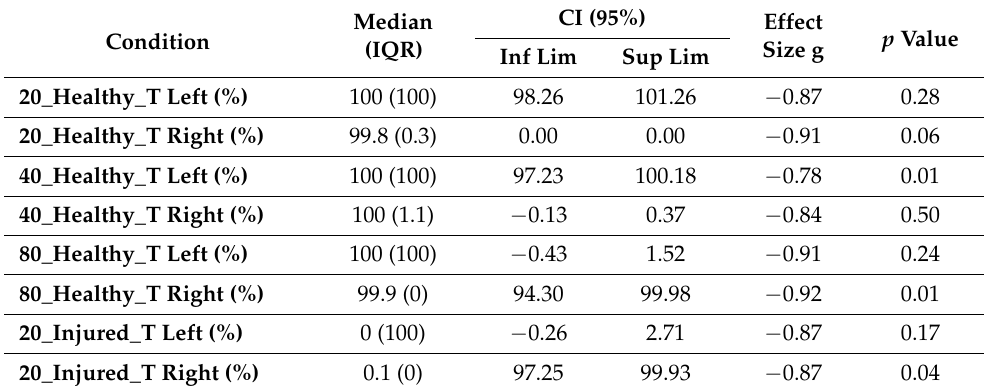
Table A2. Descriptive data (median, interquartile range, coefficient interval 95%) of echotype i, ii, iii, and iv at last day of pre-season training. changes in tendon echotypes at last day of preseason